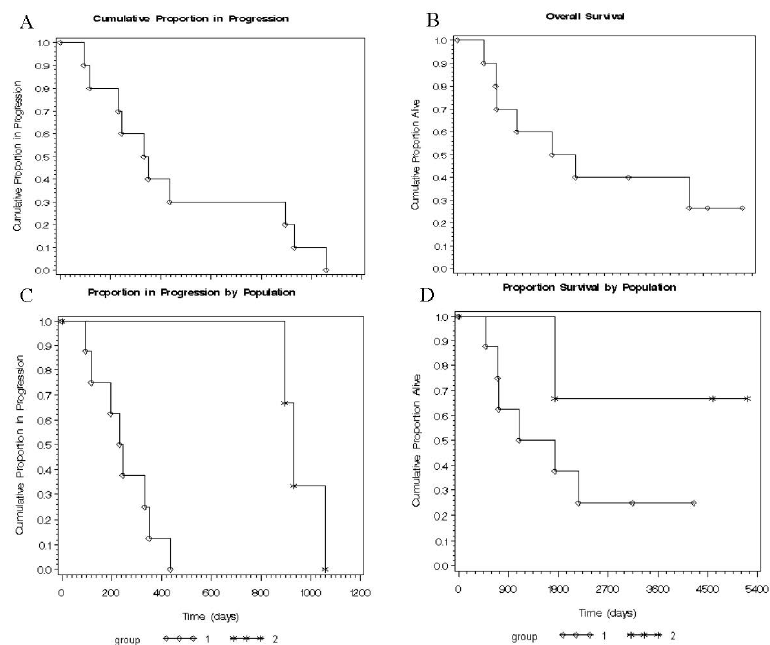
Figure 4. Kaplan-Meier curves depicting the time to progression ( A ) and overall survival ( B ) for all population (combination of group 1 and group 2); TTP (days between first surgery to second surgery for each patient of each group) ( C ) ( p = 0.0078) and OS (days between diagnosis and end-point for each patient of each group) ( D ) ( p = 0.096) of both defined groups by 3D telomere